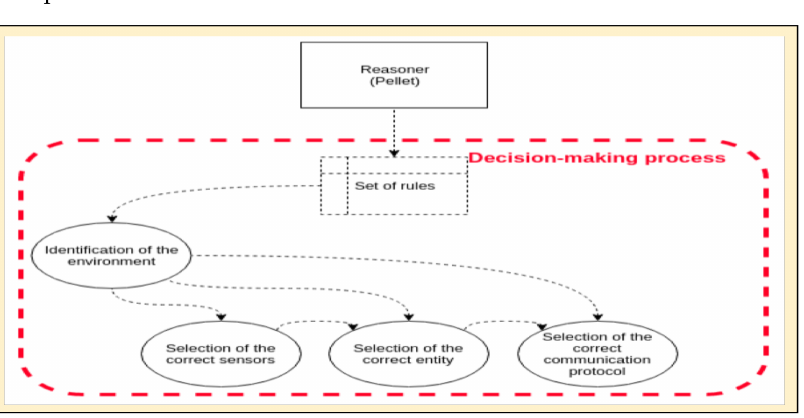
Figure 20. Decision-making process in